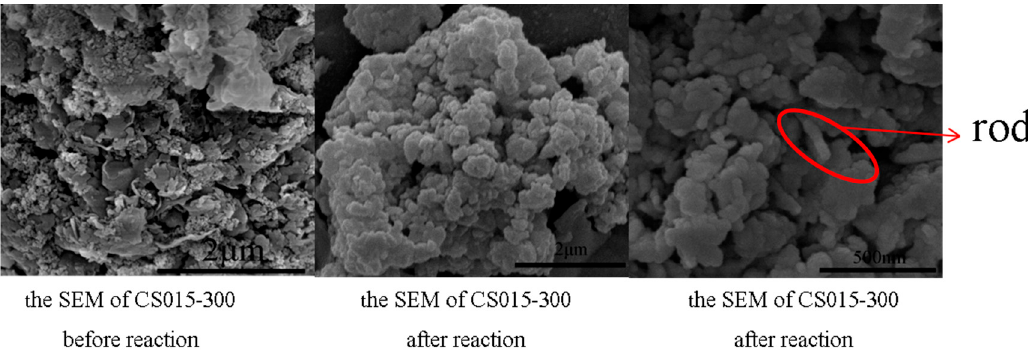
Figure 14. The SEM of CS015-300 before and after reaction.